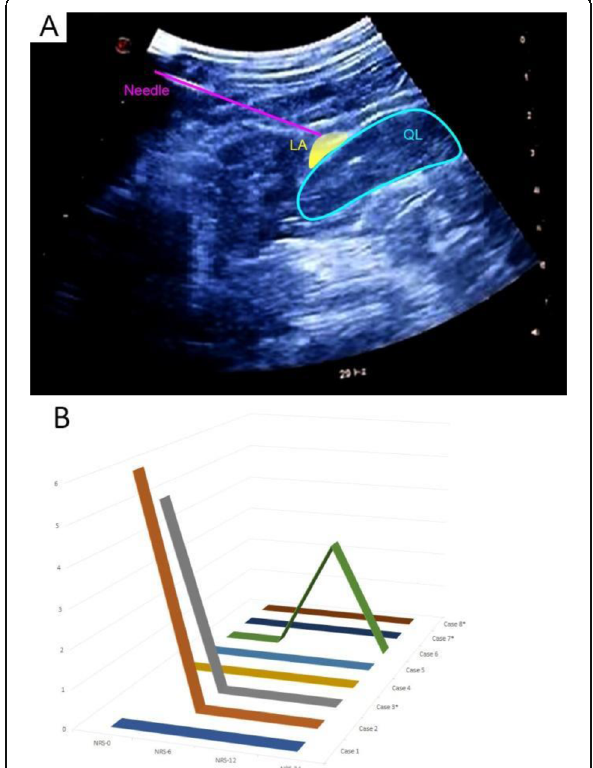
Fig. 1 (abstract A41). US-guided posterior QLB (A) and patients NRS score (B). A) LA: local anaesthetic; QL: quadratus lumborum; B) *: patients receiving intraoperative